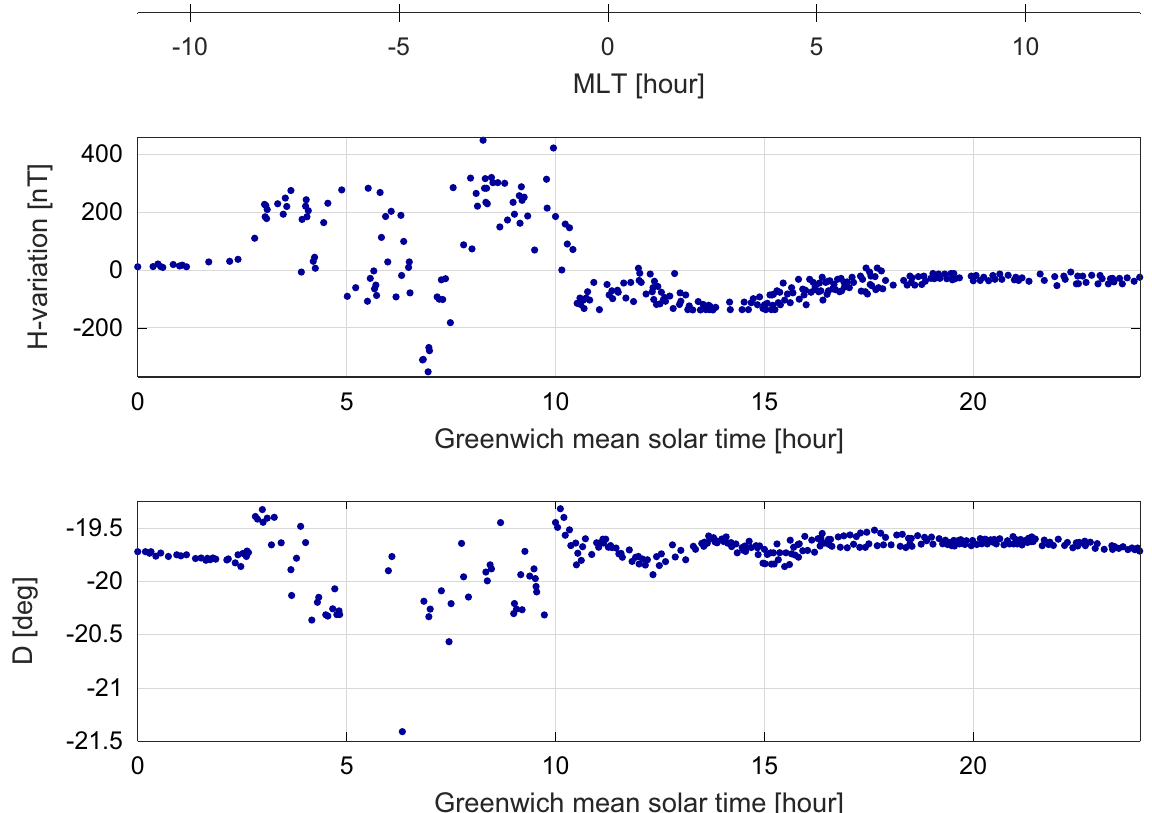
Fig. 3. The horizontal intensity and magnetic declination observed at Greenwich during the magnetic storm on 4 February 1872. The baseline value for the horizontal intensity is 18 000 nT. The additional time axis at the top of the fi gure shows the magnetic local time